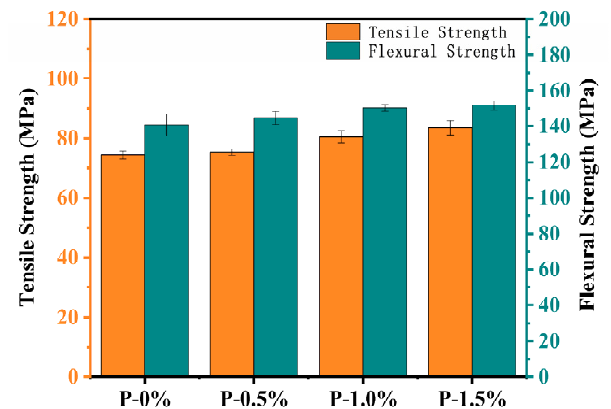
Figure 10. Tensile and flexural strengths of composites.